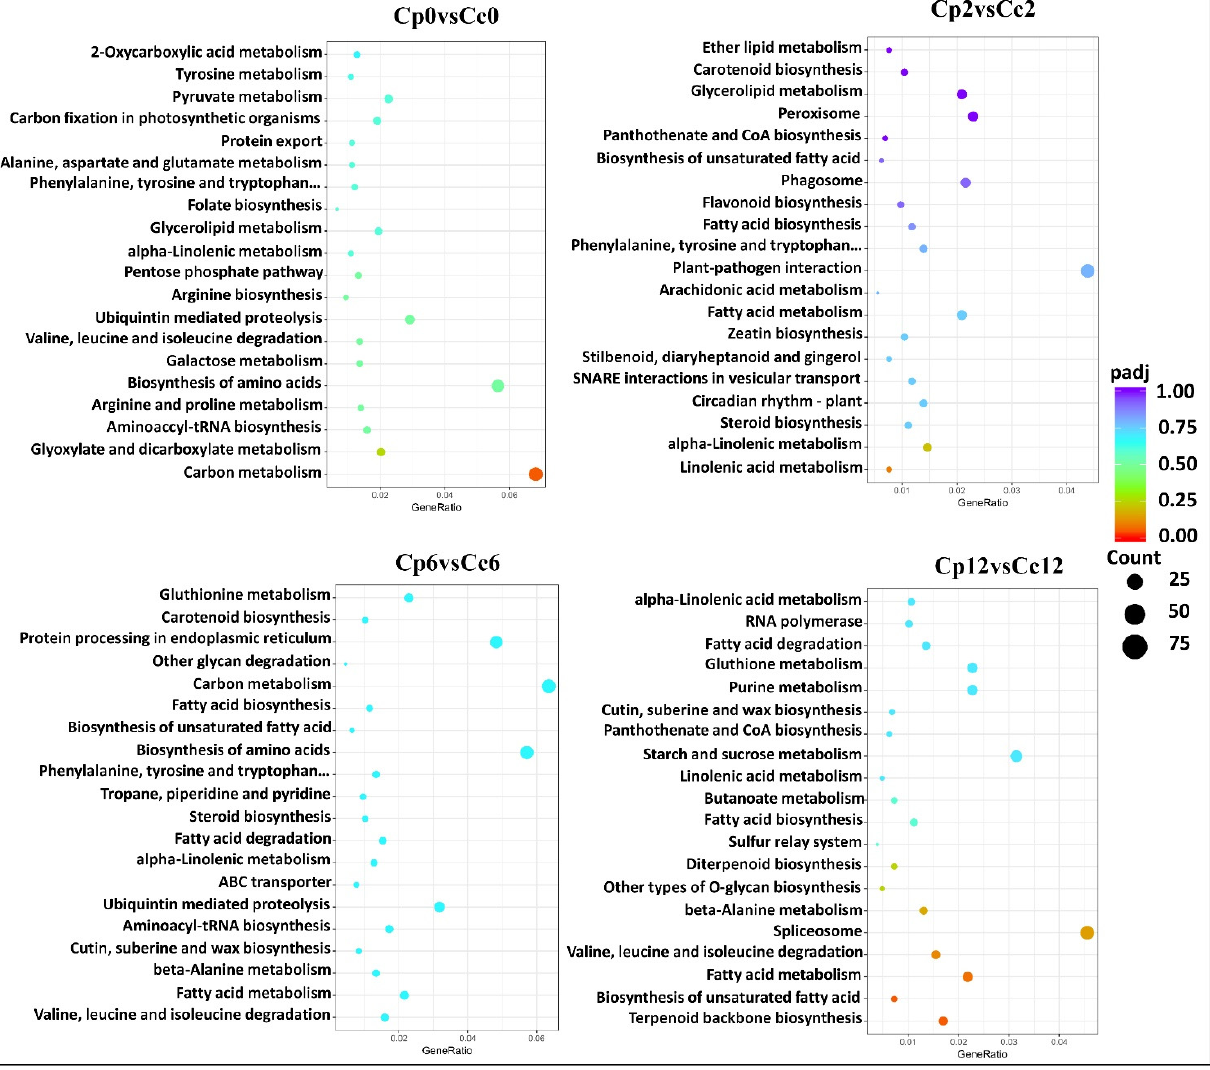
Figure 5. KEGG enrichment analysis of DEGs in the cold-treated C. pubescens and C. chinense pepper seedlings. The ordinate indicates the pathway name, and the abscissa is the enrichment factor. The size of the circle indicates the number of genes enriched in the KEGG pathway, and the color of the circle represents the p-value.